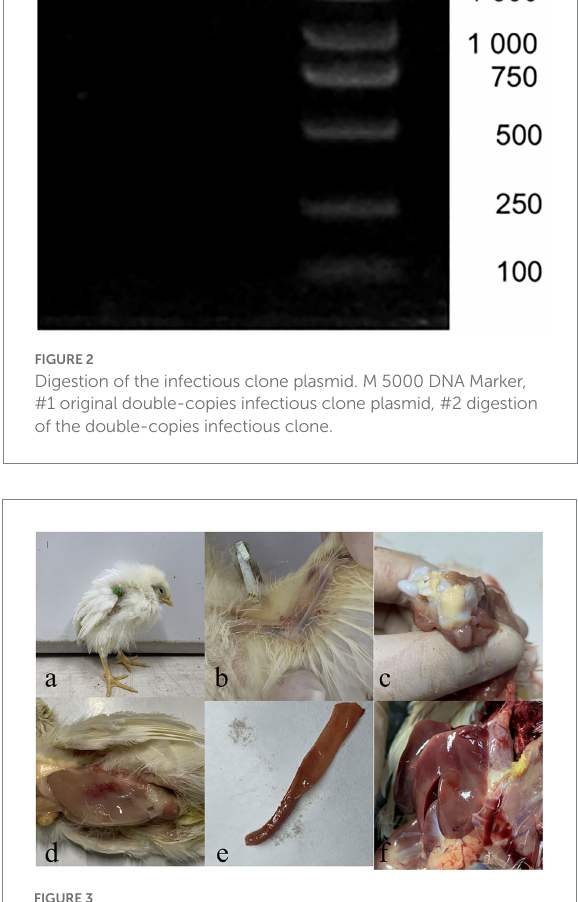
FIGURE 3 Typical clinical and pathological dissection symptoms of vaccinated chickens. (a) Chickens in in the JS2020-PFV group expressed depressed. (b) Their underwing showed bleeding, which manifested as blue wings. (c) The bone marrow was fatty. (d) The pectoral muscle showed bleeding. (e) The gut showed slight bleeding. (f) The liver had ischemia foci on the surface.